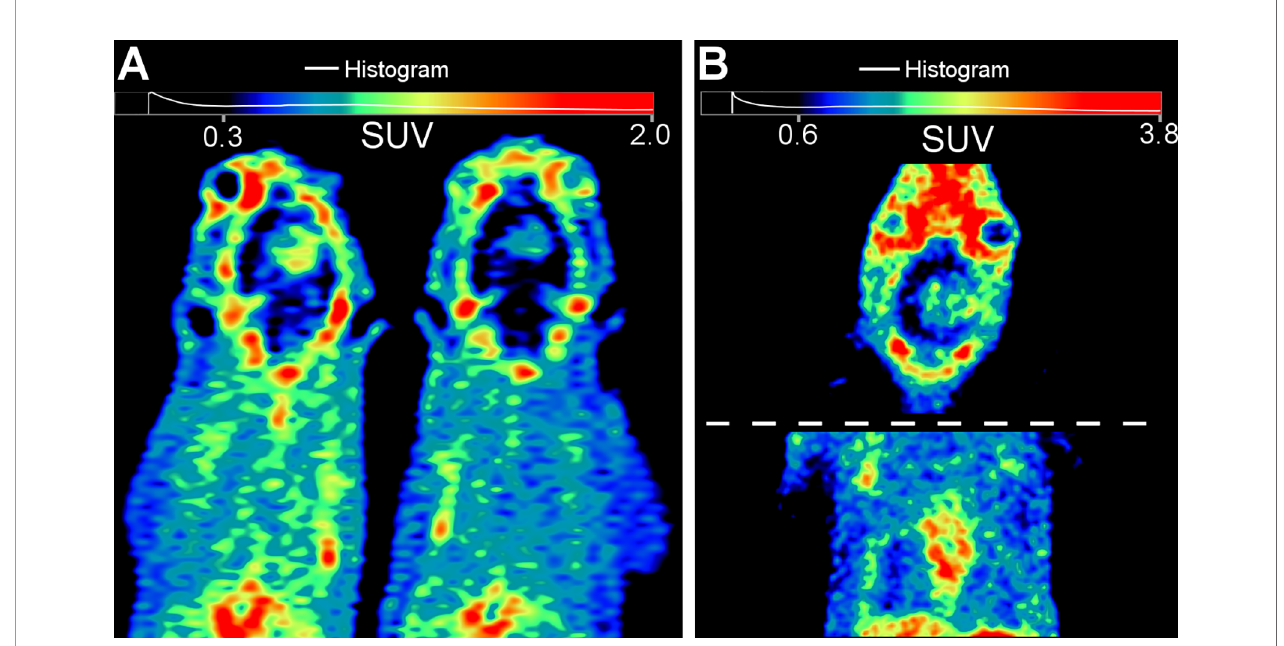
FIGURE 5 | Sample visual camera-comparison of coronal [ 18 F]FGln PET image slices with tri-cubic interpolation of time-weighted mean frames from 4 – 40 min post-injection. (A) Inveon PET/CT reconstructed with manufacturer recommendations (2 OSEM3D and 18 MAP iterations) with both subjects injected with approximately 15.2 MBq each. (B) Molecubes camera system (reconstructed with manufacturer recommendations (30 OSEM3D iterations) with the subject injected with 4.2 MBq. *note: To show similar body areas, the head and torso were split in (B) due to body positioning and gantry differences between each camera not showing the same region in a single coronal-plane slice. Additional organ and image comparisons presented in the Supplementary Materials Results